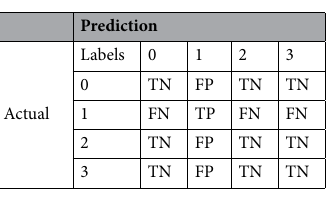
Table 2. Confusion matrix